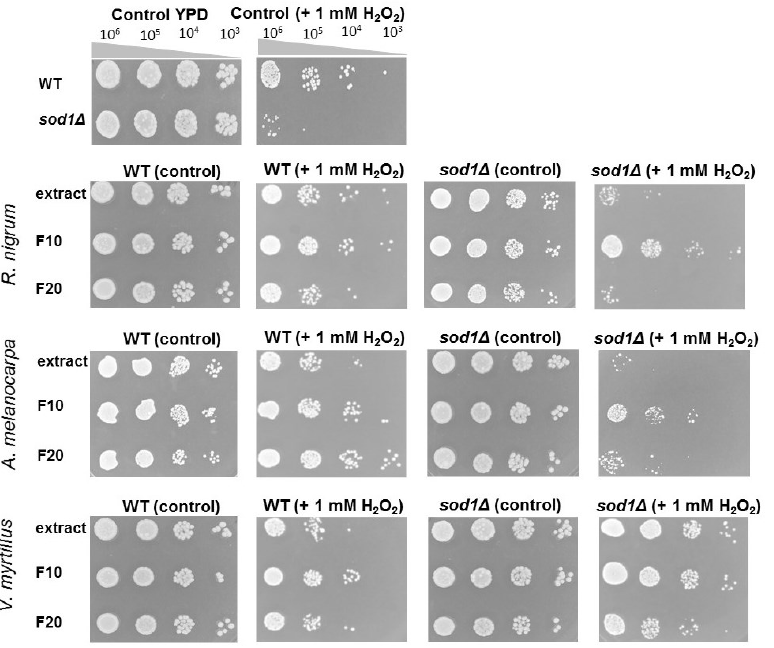
Figure 4. Spot plate assay of the wild-type BY4741 strain (WT) and isogenic mutant sod1 ∆ ( sod1 ∆ ) treated with extracts and ferments (F10 and F20) of R. nigrum , A. melanocarpa , and V. myrtillus and additionally treated with 1 mM hydrogen peroxide for 1 h (WT+ 1 mM H 2 O 2 and sod1 ∆ + 1 mM H 2 O 2 ). Strains were serially diluted (as indicated (10 6 to 10 3 ). Each spot assay was performed in